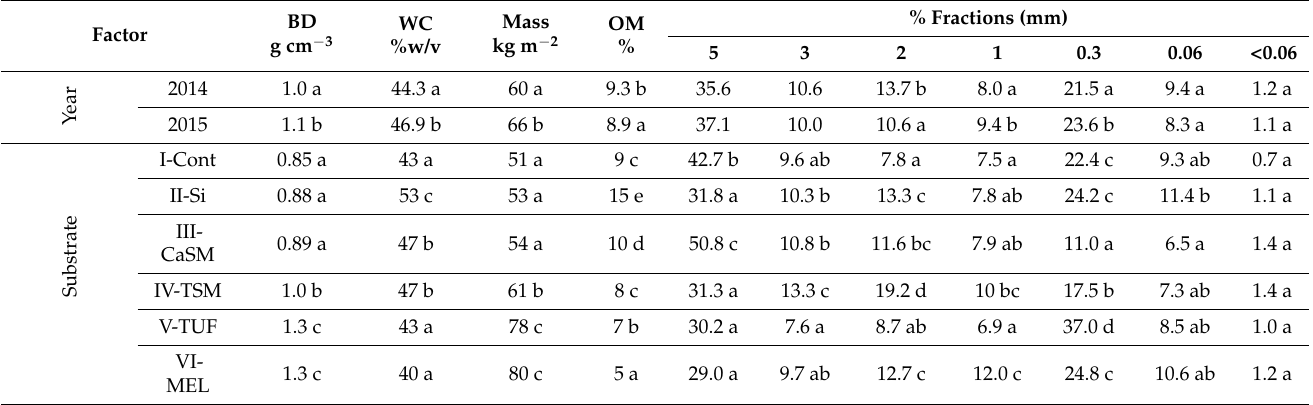
Table 6. Physical and chemical properties of green roof substrates after one- and two-year growth of Sedum acre L. (main